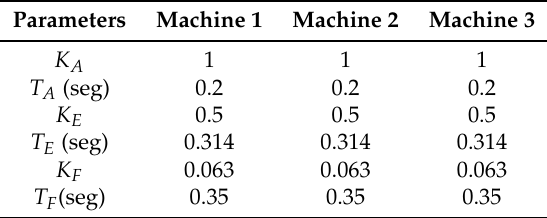
Table A3. Data from the machine excitation system.